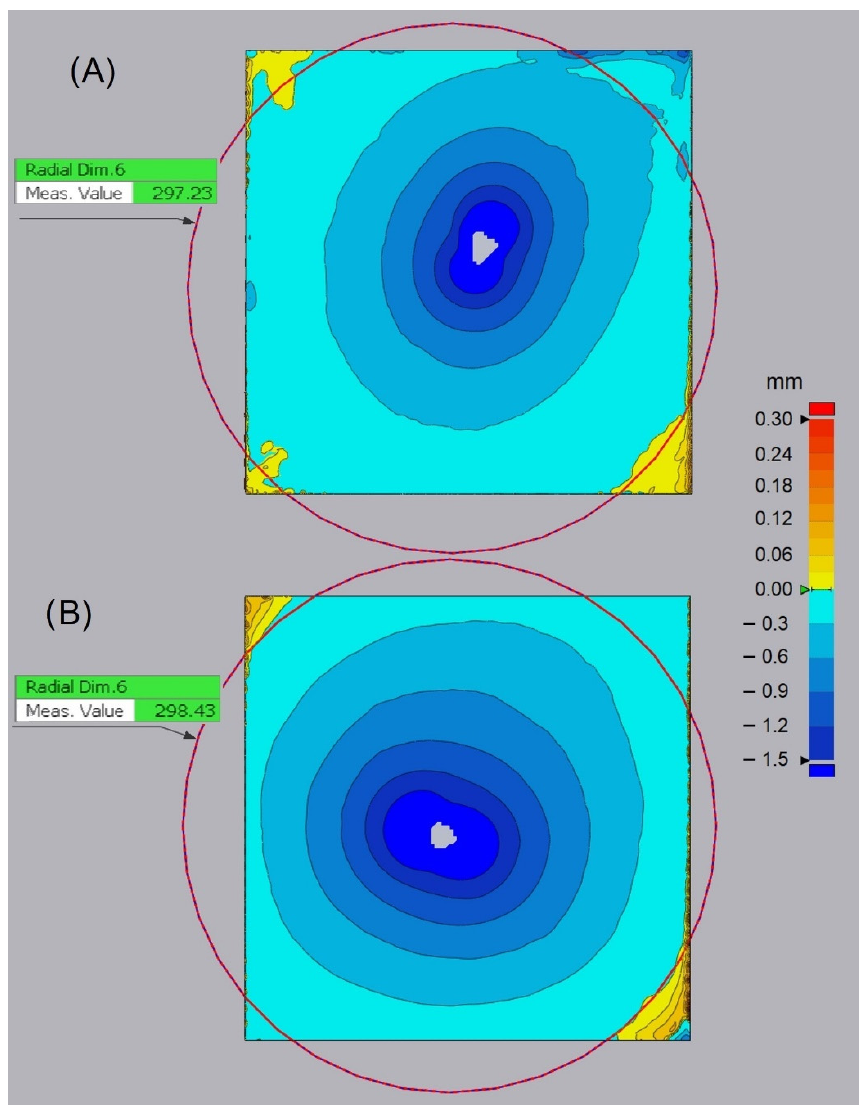
Figure 9. Deformation analysis on two panels 300 × 300 mm with an open window of 250 × 250 mm, and threshold diameter: ( A ) test 6 and ( B ) test 3 of Table 3.